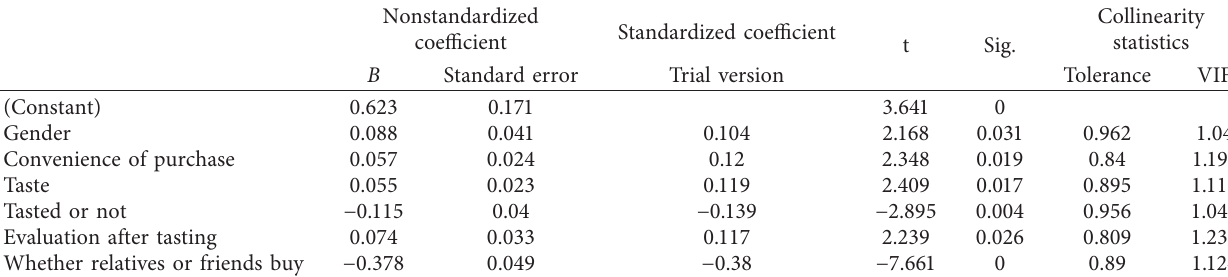
Table 9: Multiple collinearity test of the factors influencing the behavior of purchasing enterprise brand